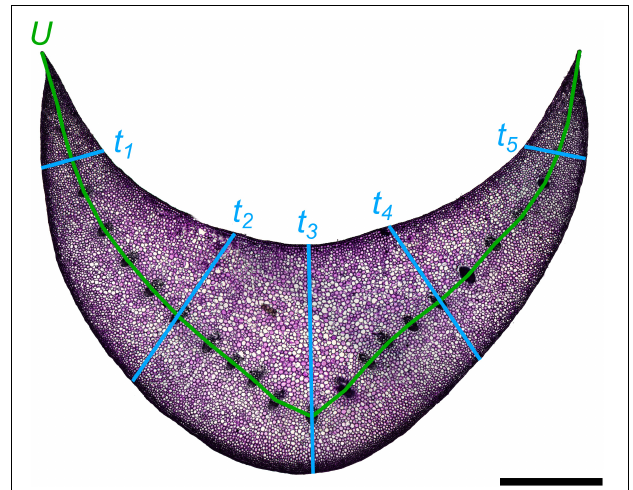
FIGURE 3 | Exemplary cross-section of the petiole of Hosta x tardiana ‘El Niño’ with five measuring points for the thicknesses ( t 1 – t 5 ) and the median line U . The scale bar is 2